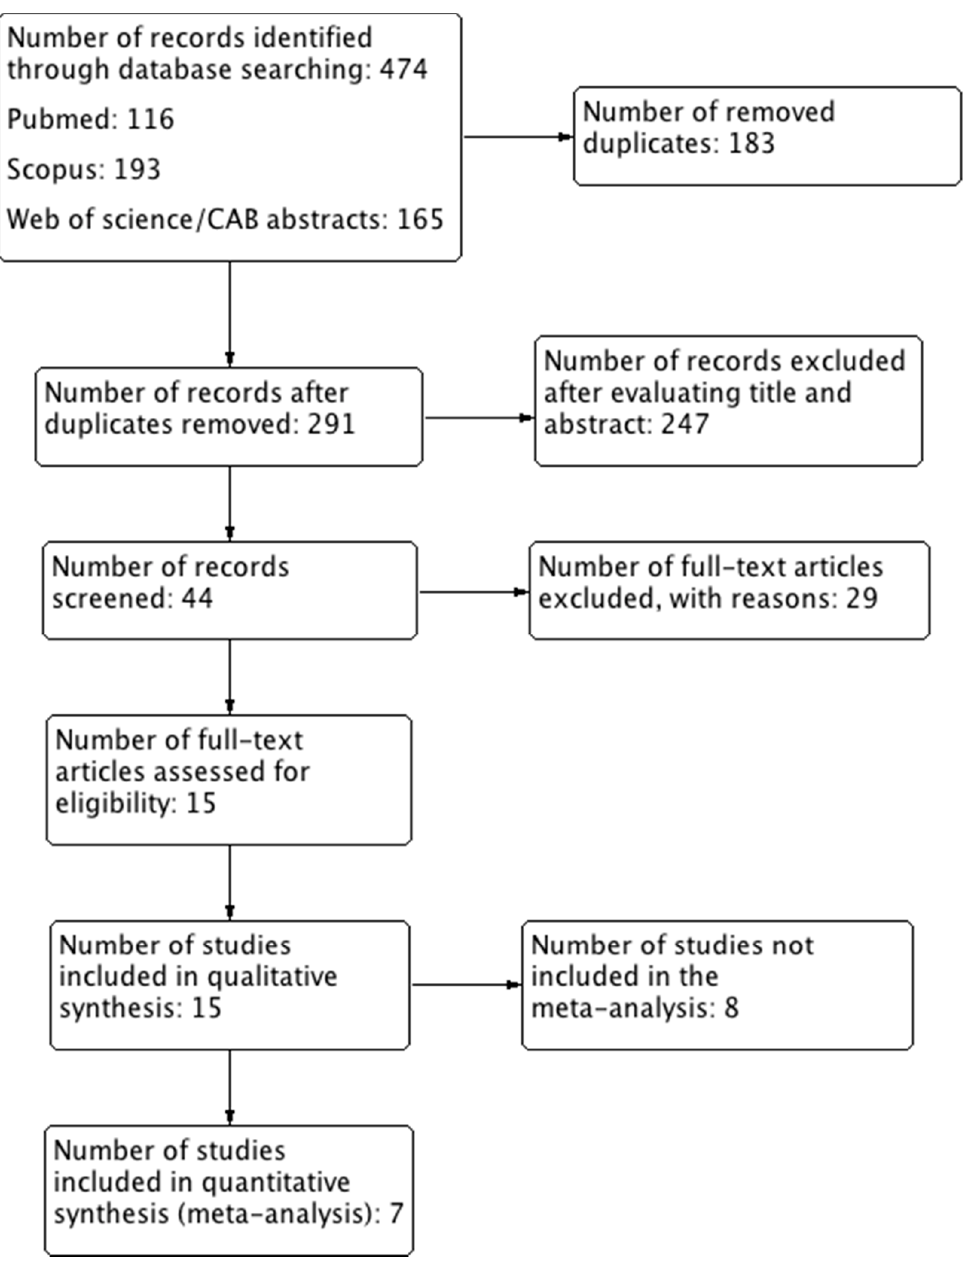
Figure 1. Study flow